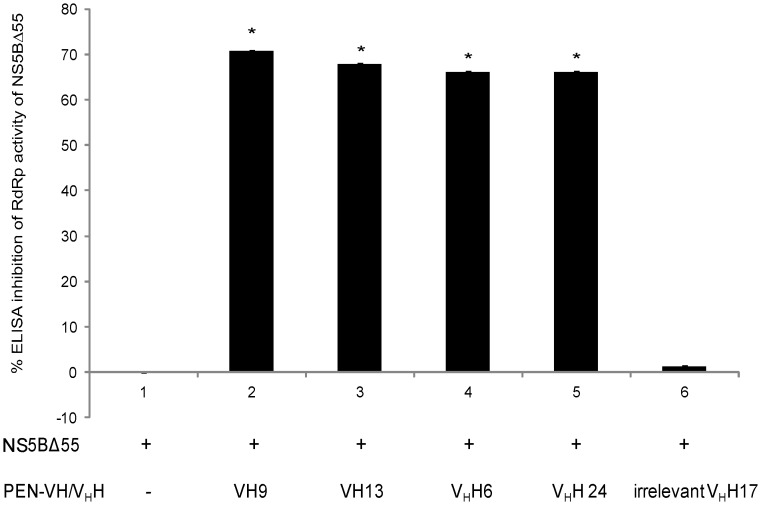
Percent ELISA inhibition of RdRp activity of NS5BΔ55 mediated by VH9, VH13, VHH6, and VHH24 (bars 2–5, respectively). ELISA mixture containing NS5BΔ55 alone (bar 1) served as negative inhibition control. Bar 6, reaction mixture containing PEN-VHH17 specific to botulinum neurotoxin type A [10] was included as background inhibition control. OD405 nm of bars 1–6 were 0.151±0.053, 0.165±0.108, 0.175±0.076 0.174±0.078 and 0.508±0.061, respectively, while the OD of the ELISA without the SdAb was 0.514±0.111. *, different significantly from the negative inhibition control.